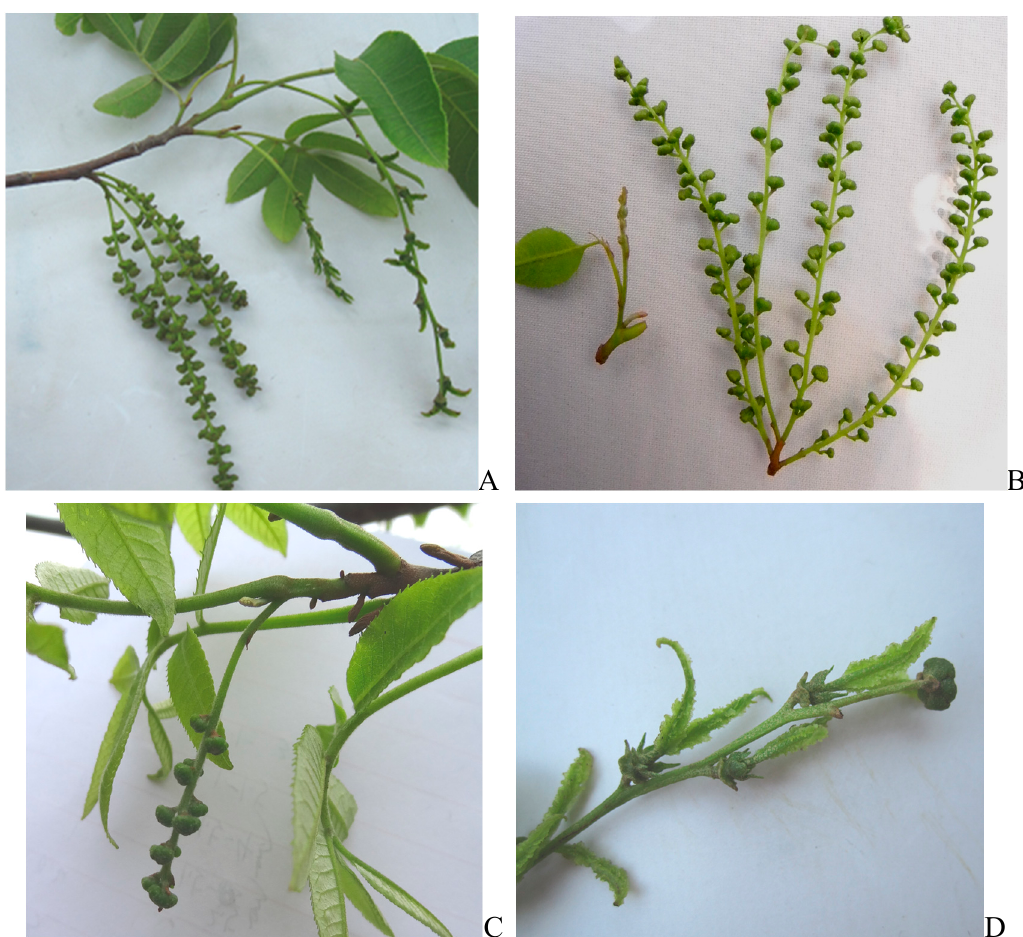
Figure 1. Expressions of male and female inflorescences in Cyclocarya paliurus . ( A ) Male and female inflorescences of the protogyny (PG) type. The female flowers are mature, while the male flowers are still enclosed. ( B ) Protandry (PA) inflorescences at the elongation stage, showing the developmental differences between the two sexual inflorescences. Abnormal inflorescences include ( C ) a single male instead of a female inflorescence at the apex of growing shoot and ( D ) a female inflorescence mixed with a male flower.